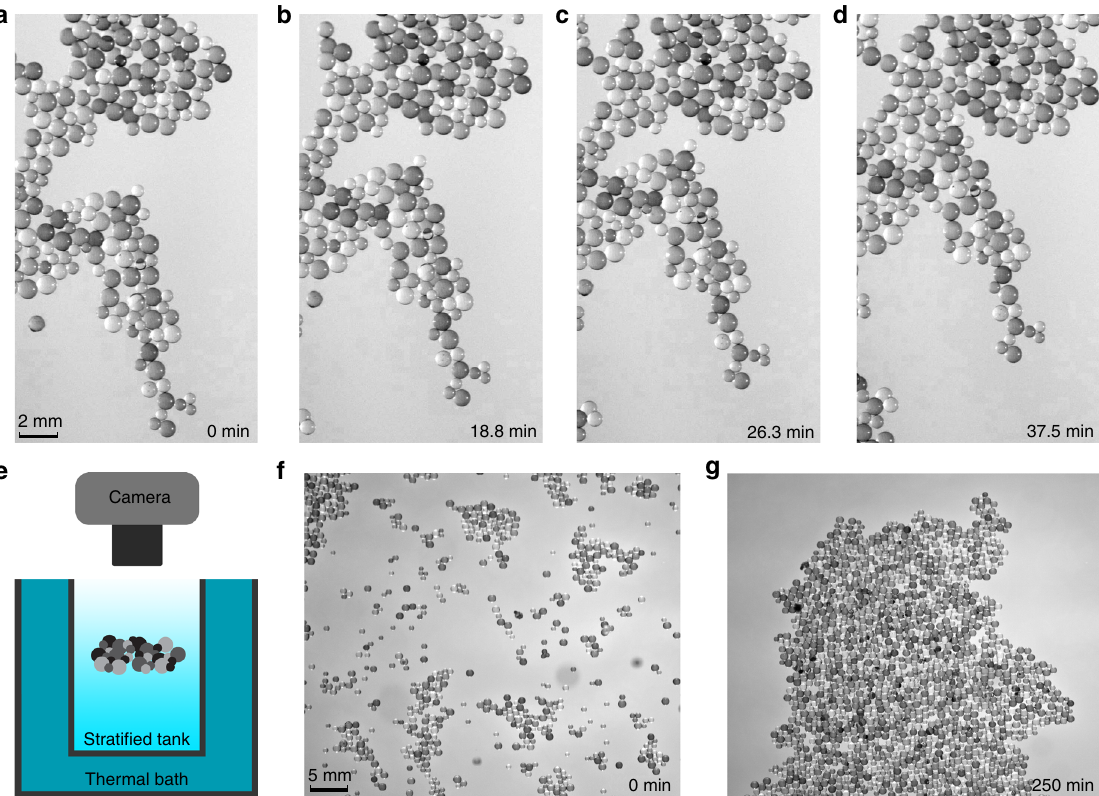
Fig. 1 Experimental snapshots and schematic. a – d Time series of self assembly of collection of neutrally buoyant spheres suspended within a sharply salt- strati fi ed fl uid viewed from above. Spheres radii and densities are 0.025 – 0.05 cm and 1 : 05 g cc − 1 , top fl uid is fresh water (0 : 997 g cc − 1 ), bottom is NaCl water solution of density (1 : 1 g cc − 1 ). e Schematic showing experimental setup. f Initial cluster (different trial). g Final cluster.